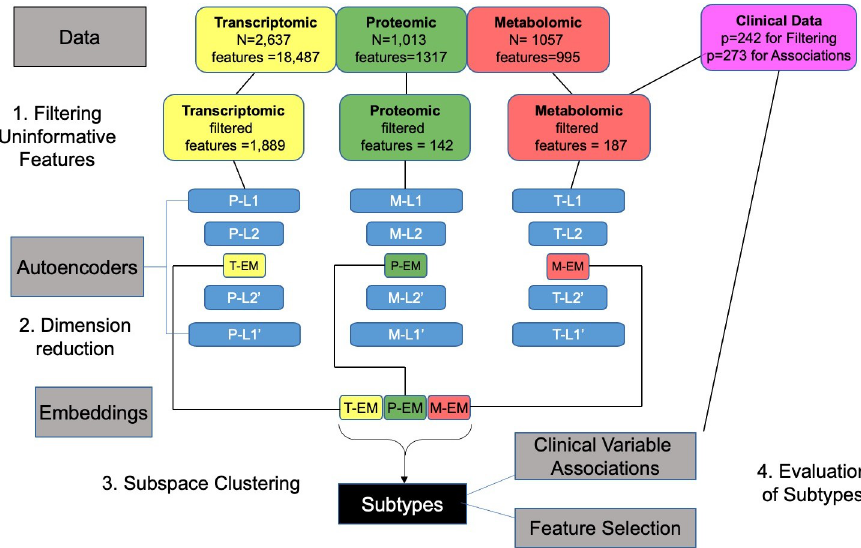
Fig 1. Flow chart illustrating -omics subtyping pipeline. T, P, and M denote the Transcriptomic, Proteomic or Metabolomic data respectively. The sample size (N) and number of features are provided for each of the individual data sets, including the Clinical data. In the first step, uninformative features were filtered by only moving forward with features that had at least one association with demographic, clinical, and imaging variables (but excluding common variables such as age and sex, as well as clinical blood count variables; p = 242 clinical variables). In the second step, dimension reduction was performed using Autoencoders where EM represents embeddings (or using PCA—not shown). In the third step, the reduced dimensions were used to cluster subjects into subtypes using subspace clustering (or k-means—not shown). Finally, the subject subtypes were evaluated in the fourth step by identifying the features (transcripts, proteins, metabolites) or clinical variables (using the complete set p = 273 of clinical variables) that discriminated between the subtypes.